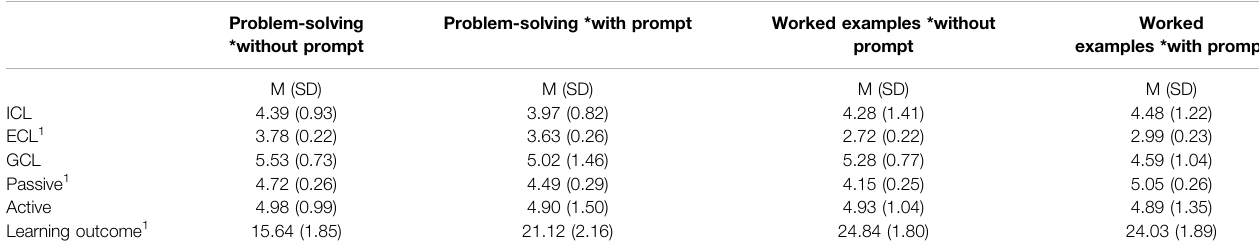
TABLE 3 | Means and standard deviation of all dependent variables in study